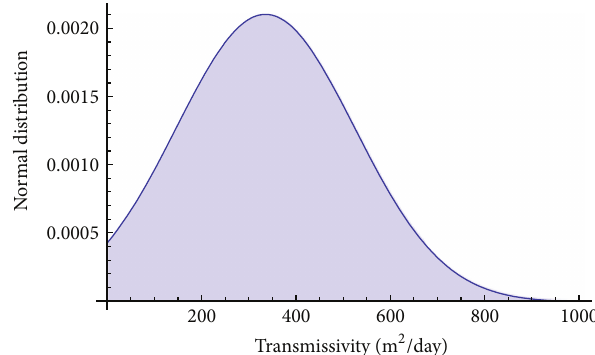
Figure 13: Normal distribution for selected transmissivity (m 2 /day).